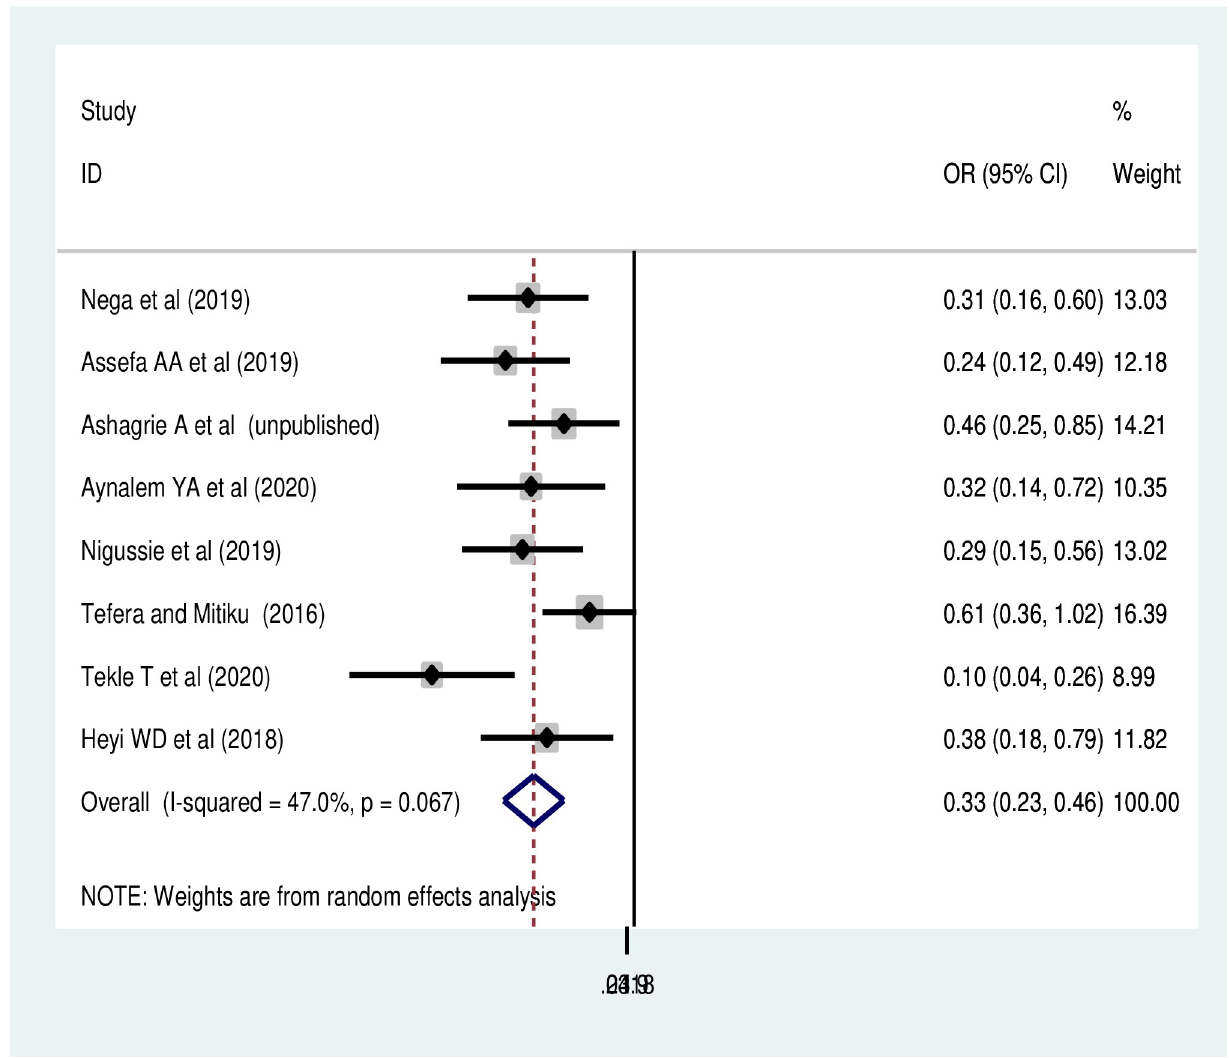
Fig 4. Association of educational status with cervical cancer screening in